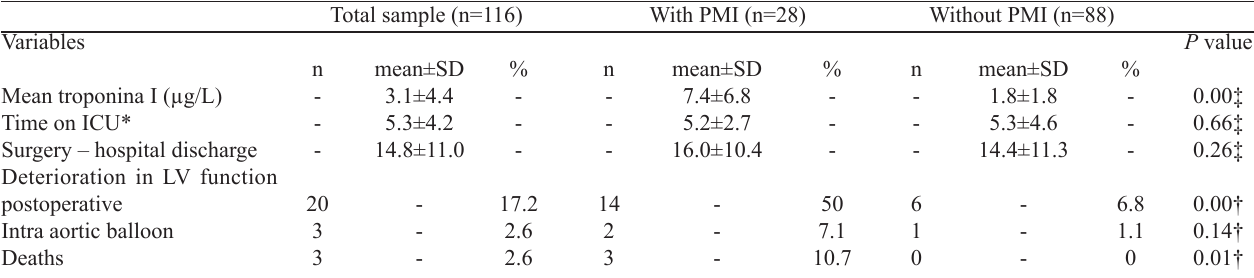
Table 3. Variables related to perioperative myocardial